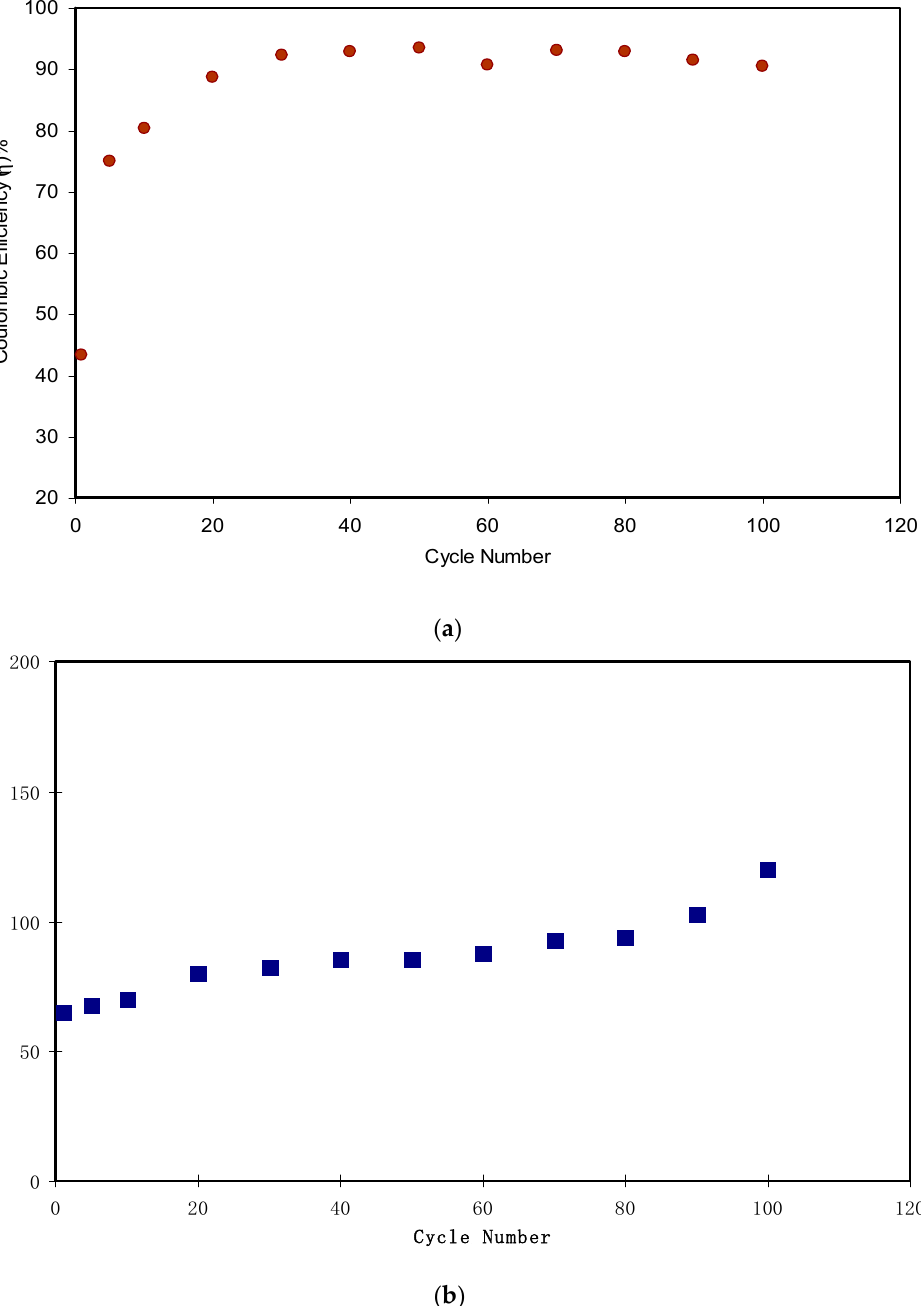
Figure 13. ( a ) E ffi ciency of the assembled EDLC for 100 cycles and ( b ) internal resistance of the assembled EDLC for 100 cycles.